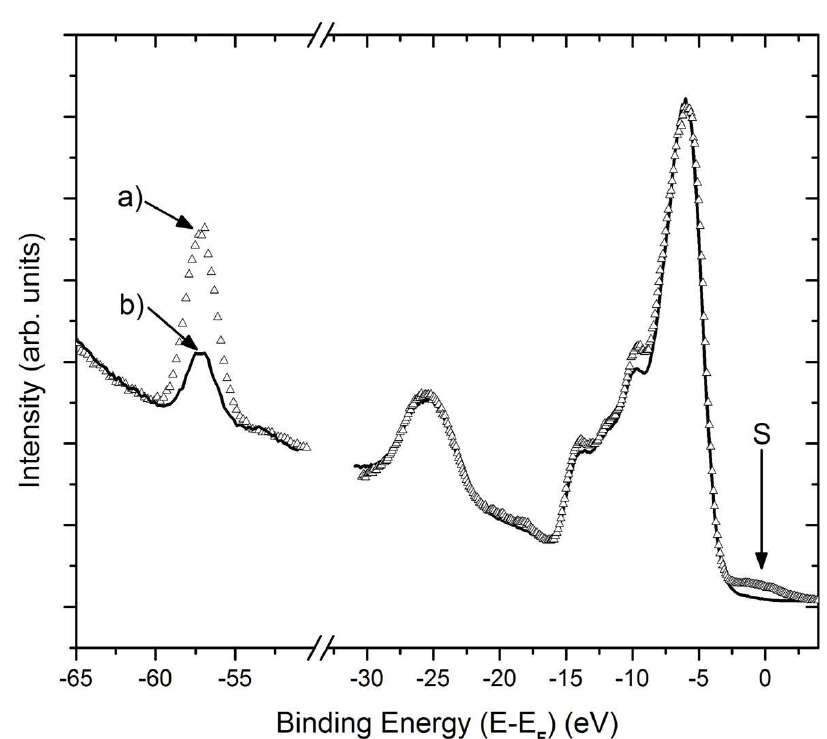
Figure 5. Experimental light polarization dependent photoemission spectra for Li B O (110) oriented along [001] with regards to the in-plane component of E . The 2 4 7 photon energy is 95 eV with the photoelectrons collected along the surface normal; the light incidence angle was ( a ) 70 degrees {∆ ∆ ∆} or ( b ) 45 degrees { ______ } with respect to surface normal. The arrow indicates the position of the surface contribution (S) to the occupied density of states above the bulk density of states valence band maximum. The sample temperature for these measurements was 623 ± 5 K, to reduce surface charging. Adapted from